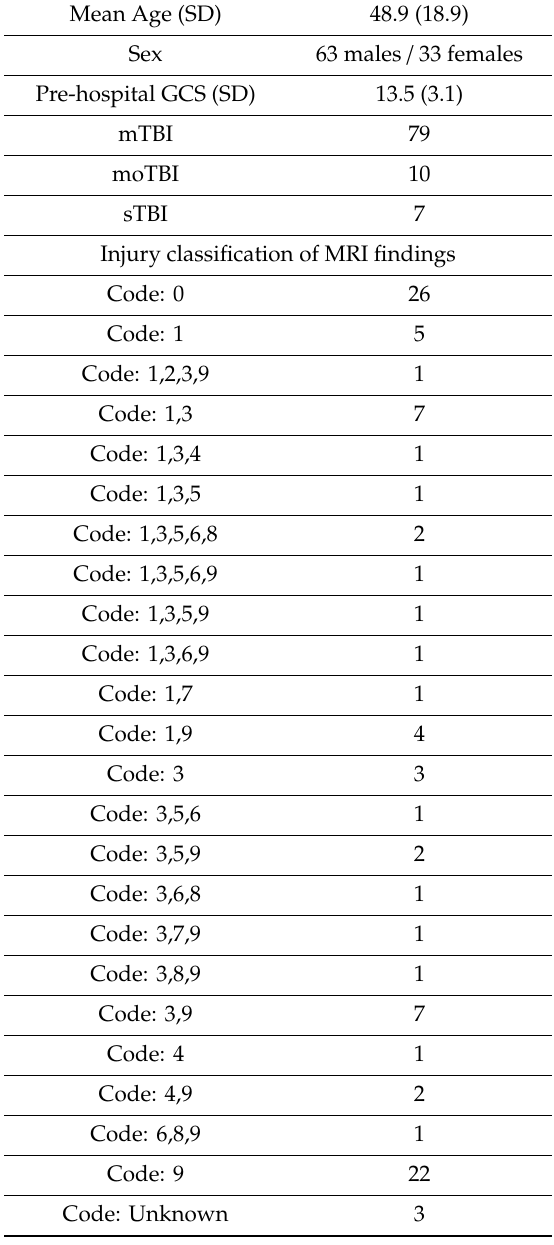
Table 1. Demographic characteristics of the study population, including injury classification of MRI findings. SD: standard deviation.